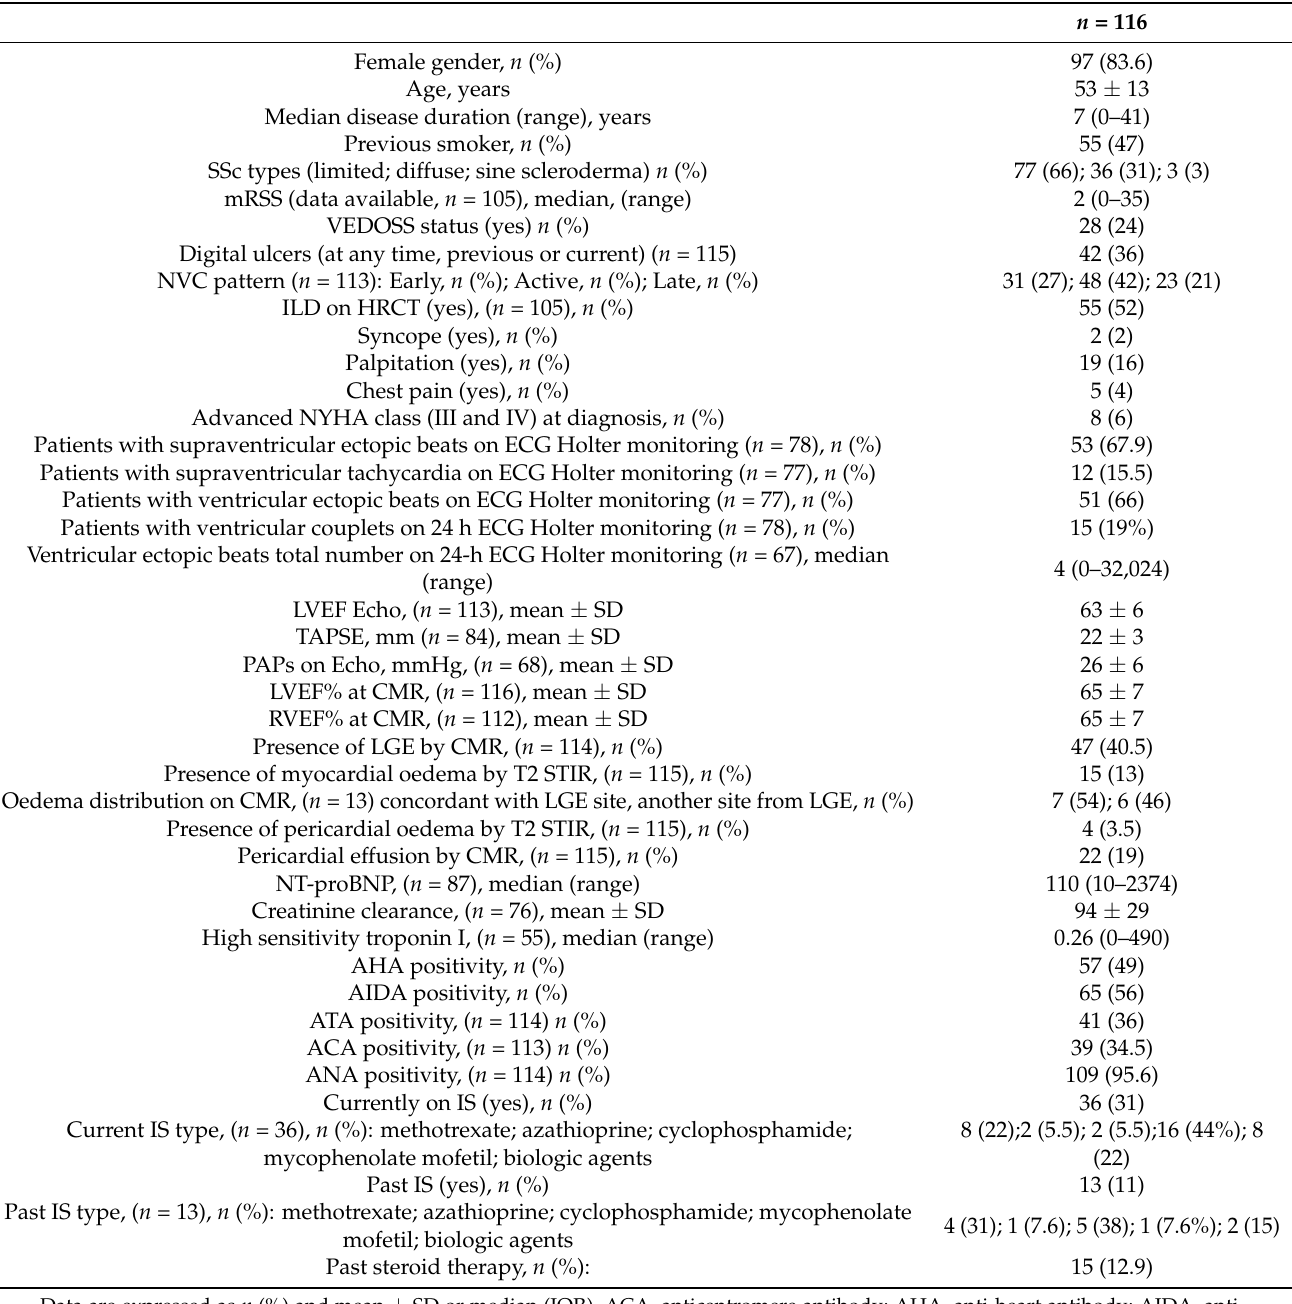
Table 1. Demographic, clinical, imaging, and immunological characteristics of SSc